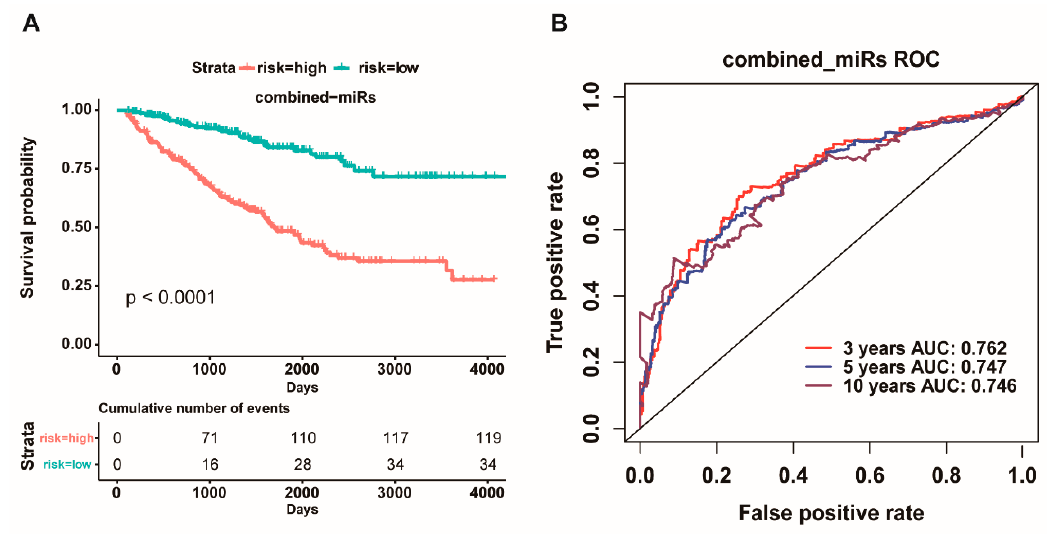
Figure 3. Kaplan Meier survival and receiver operating characteristic (ROC) curves based on the riskscore of the eight-miRNA signature. ( A ): Overall survival curves of high-risk and low-risk based on the eight-miRNA signature model. ( B ): Receiver operating characteristic (ROC) curves for high and low risk from the eight-miRNA signature model.